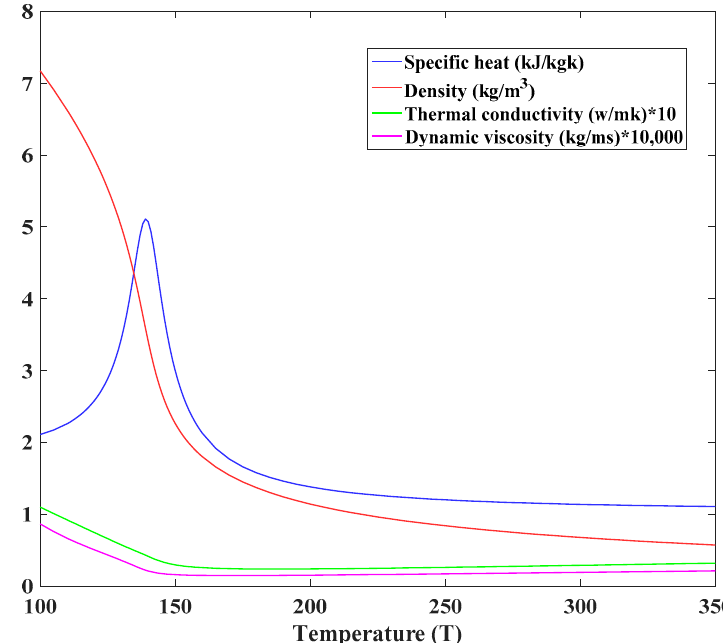
Figure 4. Thermal-physical properties of supercritical nitrogen.